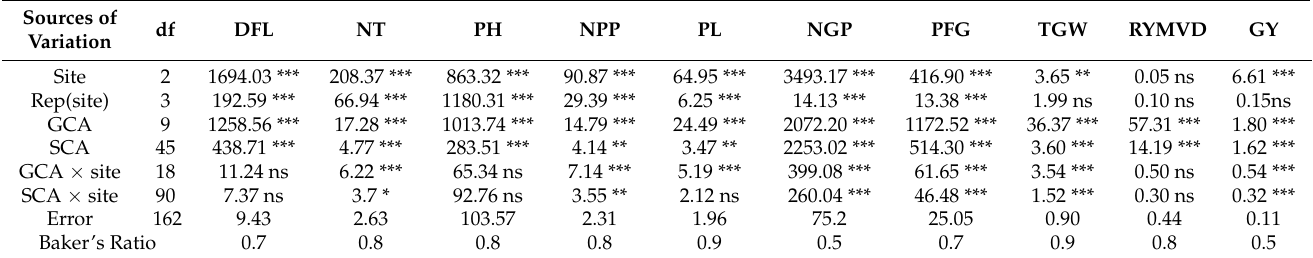
Table 6. Mean squares and significant tests of general and specific combining ability effects for agronomic traits and RYMVD reaction across three sites in Tanzania. Sources of